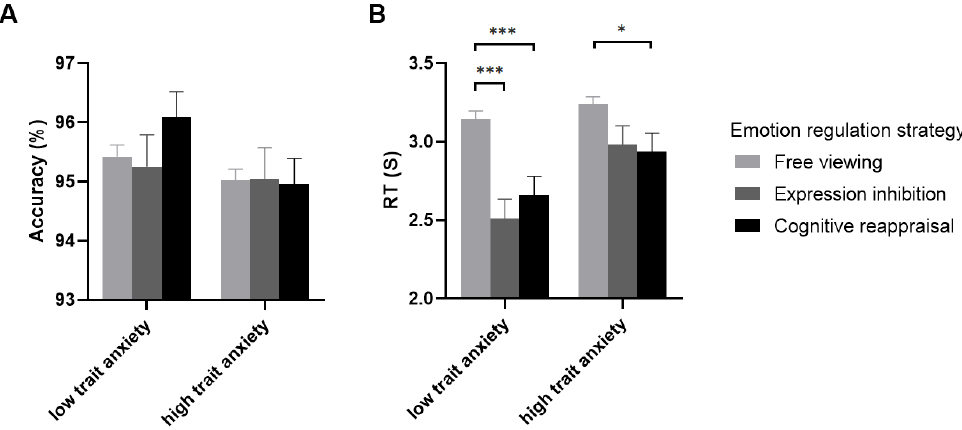
Figure 3. The accuracy ( A ) and RTs ( B ) of estimation strategy execution in the low and high trait anxiety groups after using free viewing, expression inhibition, and cognitive reappraisal to regulate negative emotions.“*” means “ p < 0.05”, “***” means “ p <